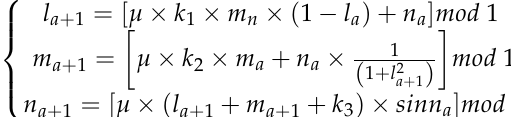
( d ) Figure 1. Distribution of intertwining logistic map; ( a ) bifurcation diagram of sequences x; ( b ) bifur- cation diagram of sequences y; ( c ) bifurcation diagram of sequences z; ( d ) Lyapunov exponents di- agram. 2.2. Block Swapping Blocks are fixed-size groups of pixels treated as one unit. They can help in improving the computational time of the cipher. In image encryption technology, a pixel is usually treated as a single unit, which is time-consuming. In contrast to that, the proposed scheme has treated 8 pixels as a single unit, dubbed a block. Figure 2 shows the block-wise swap- ping of the 8 pixels. Figure 2. Block-swapping row-wise: ( a ) the initial state of the image; ( b ) the highlighted blocks; ( c ) the state of the image in ( a ) after block-swapping. 3. Proposed Block-Based Image Encryption Scheme In this section, we discuss how the chaotic data were generated as well as the sug- gested scheme for the encryption of images.